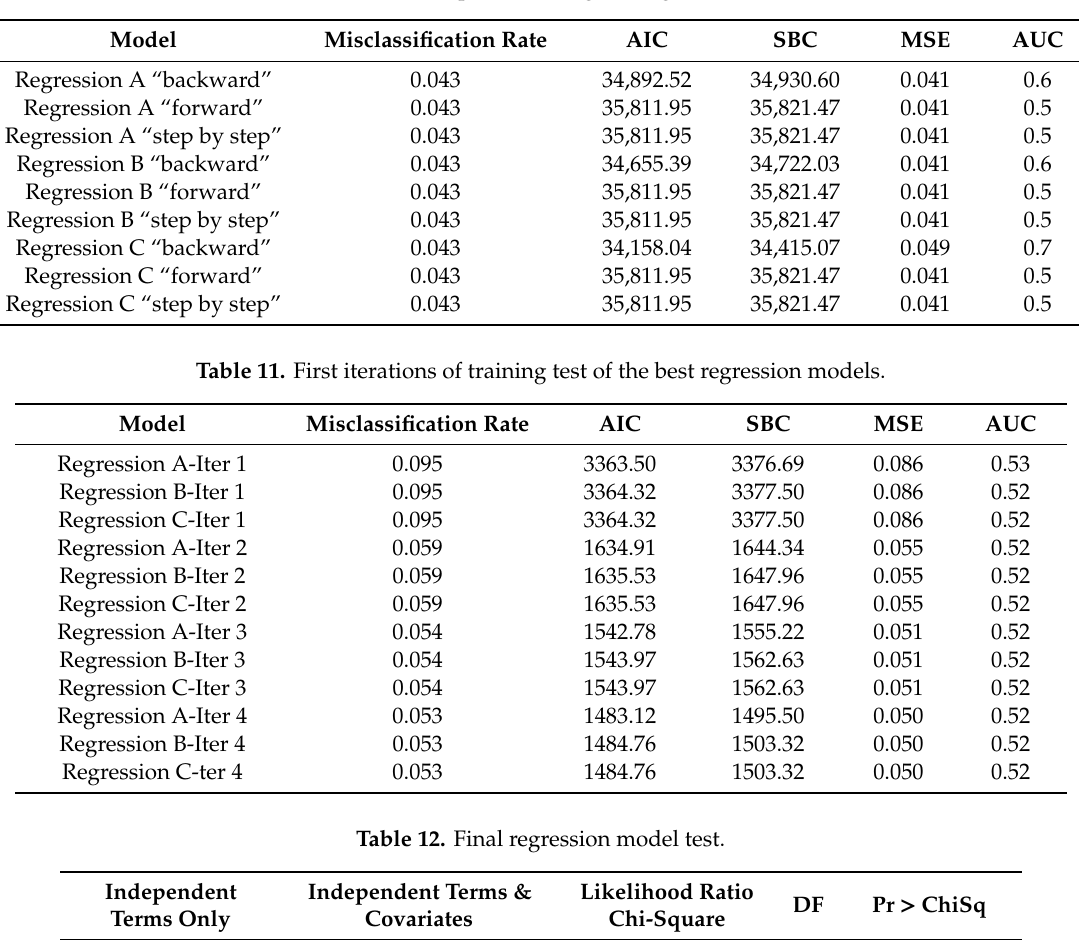
Table 10. Initial comparison of logistic regression models.